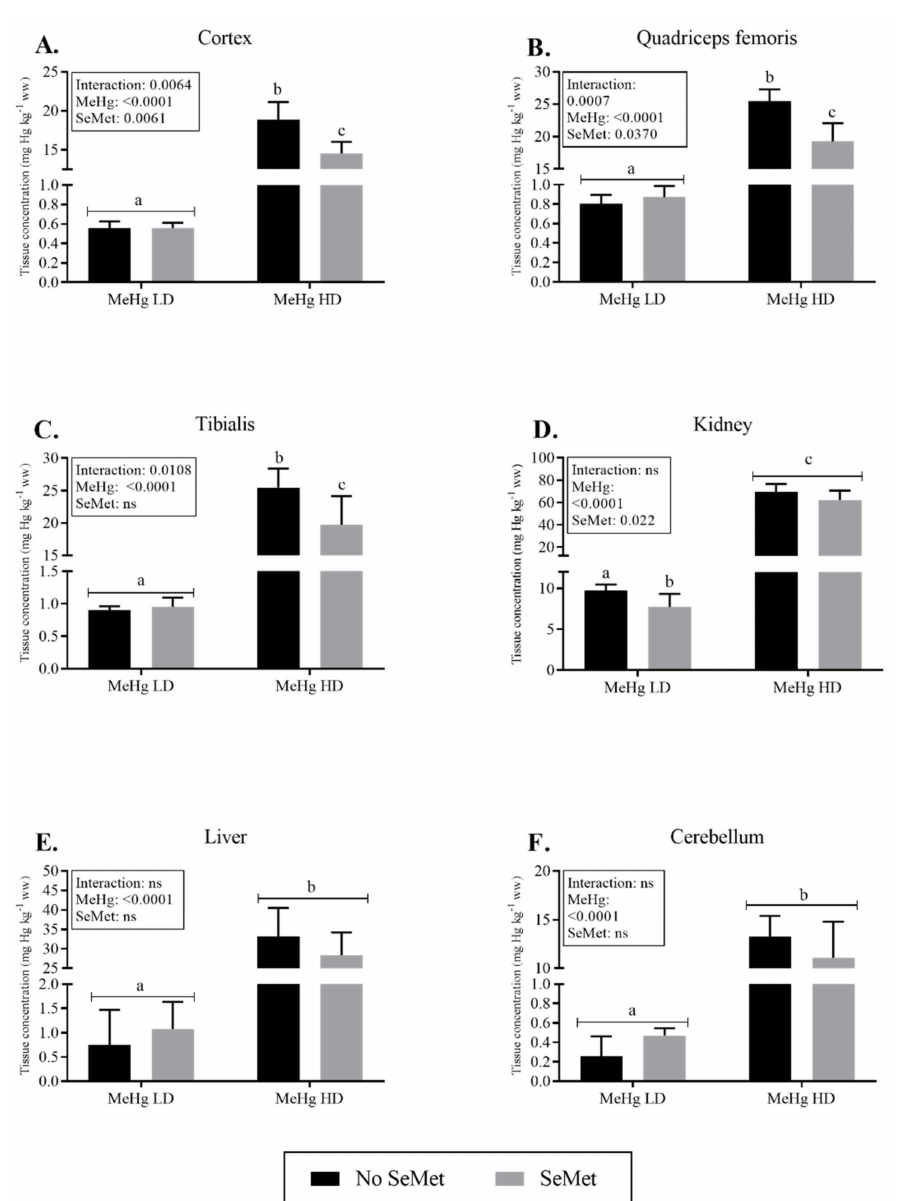
Figure 1. Total Hg concentration (mg Hg kg − 1 ww) in cortex ( A ), quadriceps femoris ( B ), tibialis ( C ), kidney ( D ), liver ( E ) and cerebellum ( F ) of adolescent BALB/c mice exposed to dietary MeHg (0.28 and 5 mg Hg kg − 1 feed) with or without supplementary SeMet for 11 weeks. All results are presented as means with 95% CI ( n = 6). The box in each graph denotes p -values from two-way ANOVA analysis showing MeHg (main effect), SeMet (main effect) and interaction effect between MeHg and SeMet. Different lowercase letters represent statistical significance ( p < 0.05) between the groups analyzed with the post hoc test Tukey’s multiple comparisons test. Statistics are based on log transformed (log 10 ) data ( A – D ) and robust statistics ( E , F ) while figures present raw data. The bars representing mercury levels in cortex ( A ) have been presented previously for the groups MeHg LD and MeHg HD [41] but are still presented here for comparative purposes between the mercury levels in mice with and without the supplementary SeMet in the diet. Abbreviations: MeHg, methylmercury; SeMet, selenomethionine; LD, low dose; HD, high dose; ns, not